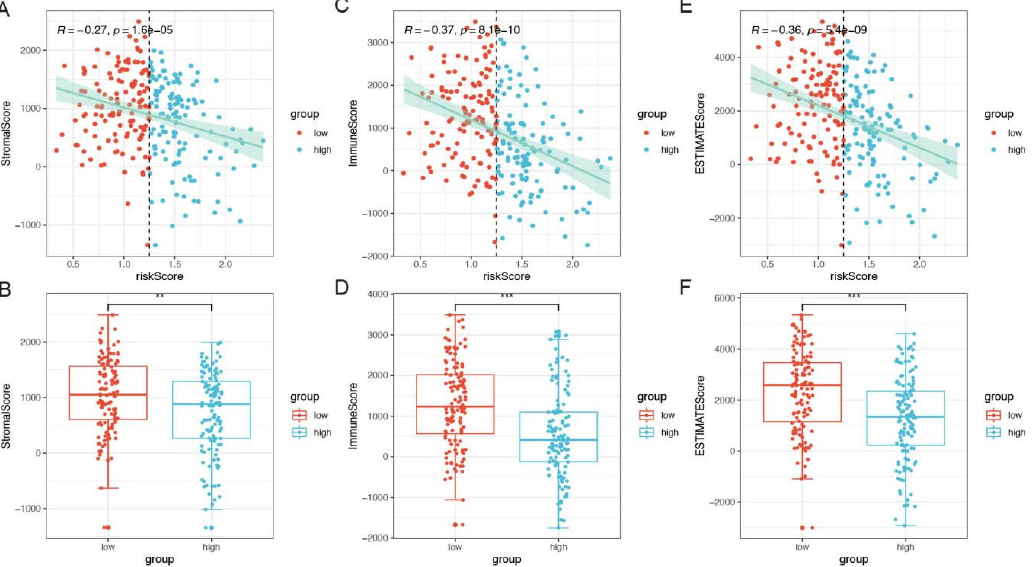
Figure 8. The association of CRGs with immune scores. ( A – F ) Immune scores, stromal scores, and ESTIMATE scores of five CRGs signatures between the high- and low-risk groups. Immune and stromal scores were calculated by analyzing specific gene expression signatures of immune and stromal cells to predict non-tumor cell infiltration. ** p < 0.01. *** p < 0.001.